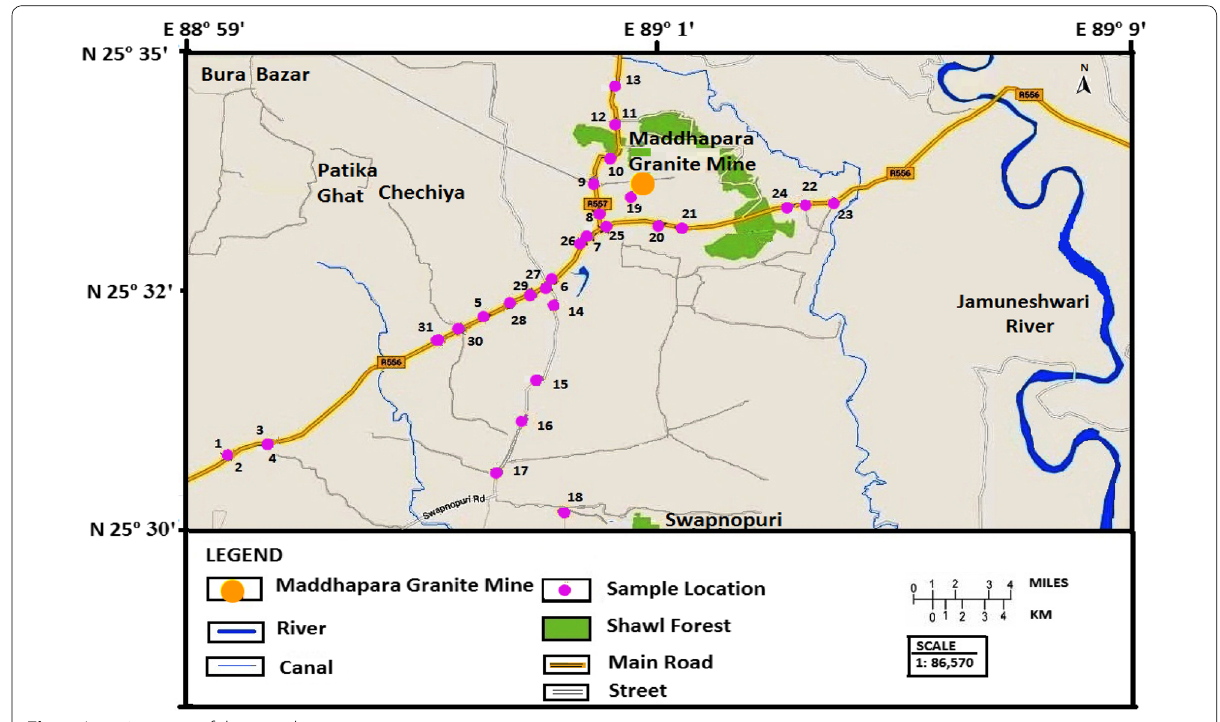
Fig. 5 Location map of the samples